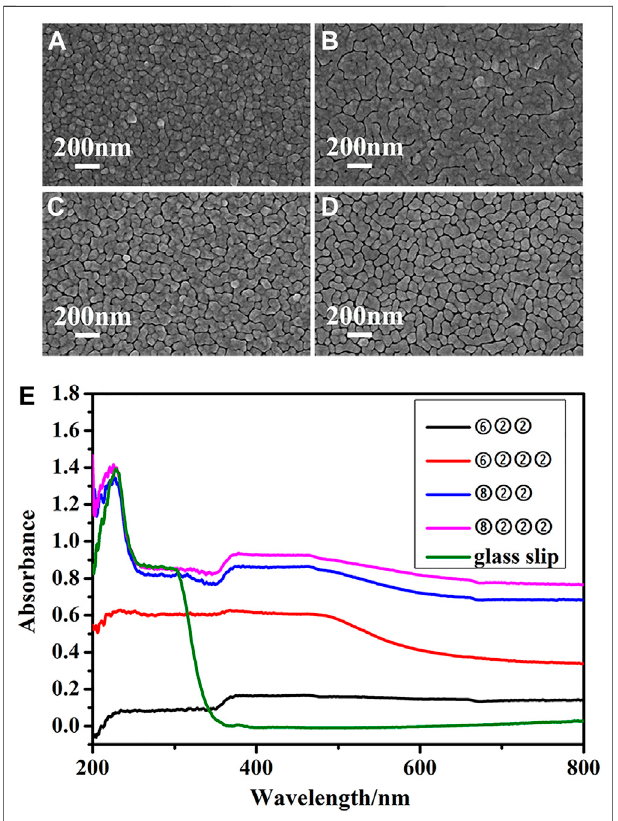
FIGURE2| SEMimagesofsubstratesobtainedbyadjustingthenumber ofgrowthcyclesandtheamountofgrowthsolutionto (A) threegrowthcycles: ⑥②② (B) four growth cycles: ⑥②②② (C) three growth cycles: ⑧②② (D) four growth cycles: ⑧②②② and (E) SPR re fl ection characterization of the above substrates.